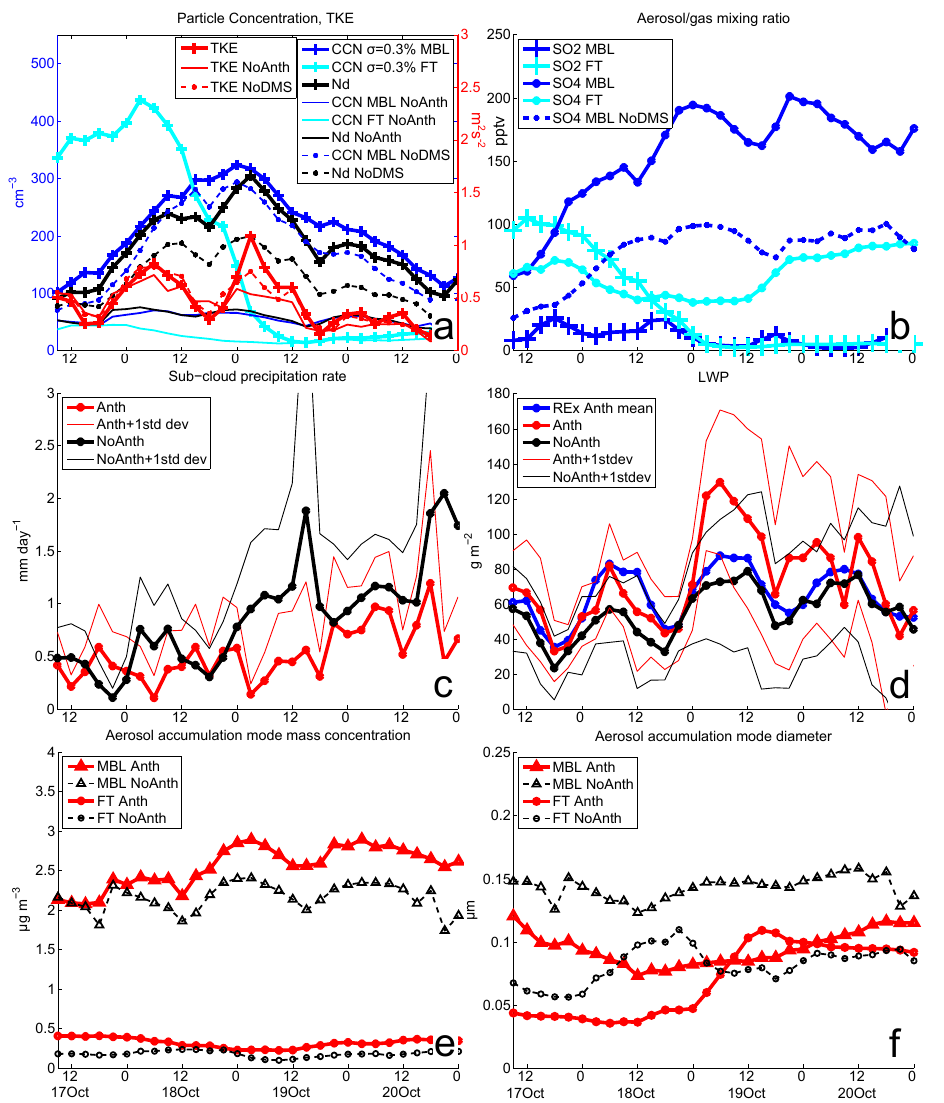
Fig. 8. Average of cloud and aerosol properties interpolated along 95 2-D hook trajectories, computed in the same manner as those marked Fig. 6, both in the model layer just above the inversion (FT) and in the MBL at the cloud level. (a) FT CCN (cyan) and MBL CCN (blue) at 0.3% SS with N d (black) and turbulent kinetic energy (red). The Anth simulation has “+” markers. Lines without markers are the NoAnth simulation and circle markers with dashed lines indicate the NoDMS simulation. (b) SO 2 (“+”) and SO 4 (circles) in the FT (cyan) and MBL (blue). The dashed blue line indicates NoDMS MBL SO 4 . In (c–f) properties in the Anth (red) and NoAnth (black) are compared. Thin solid lines indicate 1 standard deviation outside the mean of hook points. (c) Precipitation rate simulations at sub-cloud level. (d) LWP and REx mean LWP at the same time of day at hook trajectory locations (blue). Accumulation-mode aerosol mass and computed accumulation-mode diameters are shown in the (e) and (f) in the MBL (triangles) and FT